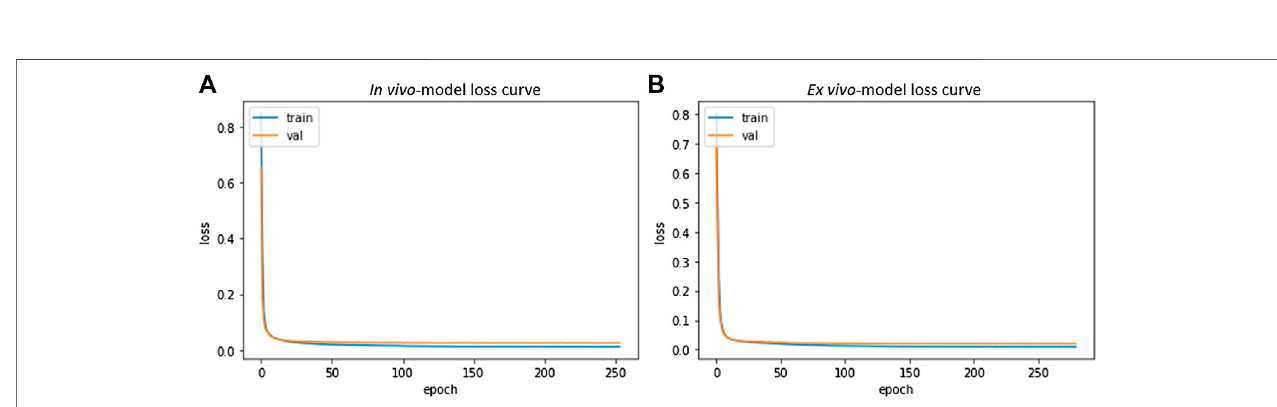
FIGURE 6 | Skull Stripping Model-Loss curve. The smooth decay of validation loss for both in vivo (A) and ex vivo (B) demonstrate convergence of the learning process and a good fi t for the resulting